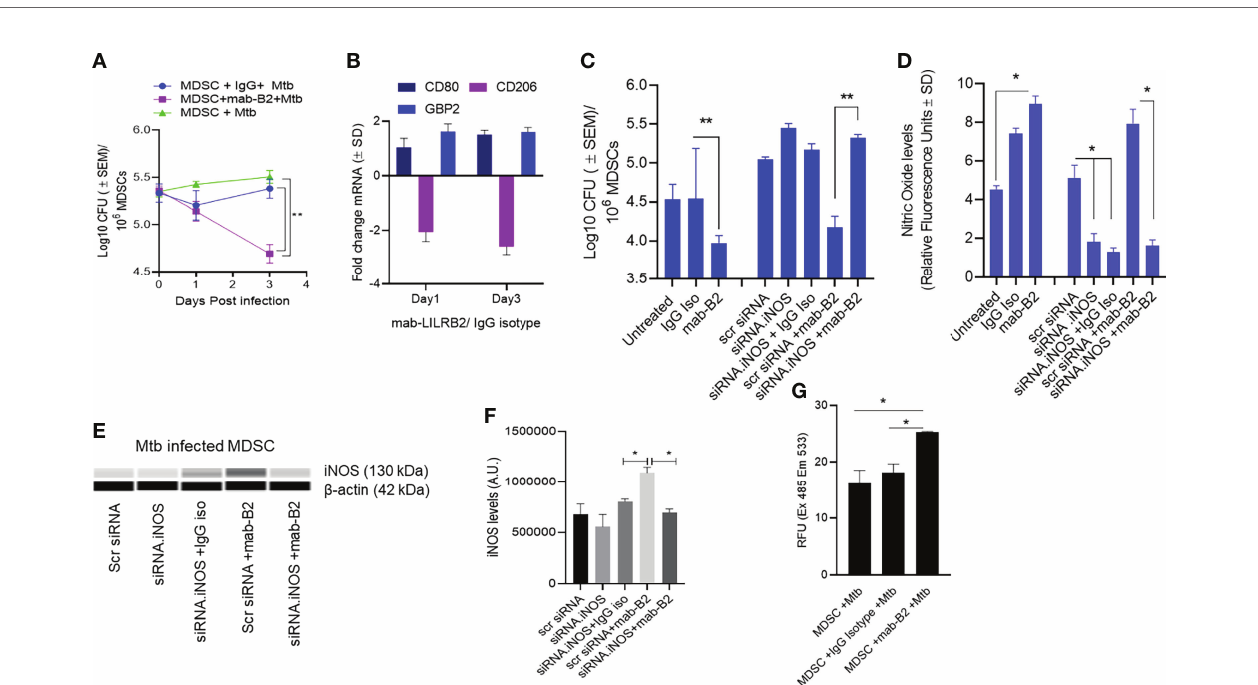
FIGURE 2 | A monoclonal antibody to leukocyte immunoglobulin-like receptor B2 (LILRB2) enhances the killing of Mycobacterium tuberculosis (Mtb) in MDSCs through nitric oxide. (A) CD14 + /CD33 + bead-puri fi ed M-MDSCs derived from GM-CSF/IL-6 cultured PBMCs of a healthy donor were infected for 4 h with Mtb H37Rv (MOI = 1), washed, and activated using either a monoclonal antibody to LILRB2 (mab-B2; 1 µg/ml) or its IgG isotype (1 µg/ml) or left untreated. MDSC lysates were plated at indicated time points for Mtb CFUs on 7H11 agar (triplicate wells per point; ** p < 0.007 1-way ANOVA and Tukey ’ s posttest; 1 of 2 similar experiments shown). (B) At indicated time points, MDSC cell lysates in trizol were collected for qPCR for CD80, CD206, and Guanylate binding protein-2 biomarkers (1 of 2 similar experiments shown). (C) MDSCs were treated with siRNA vs. inducible nitric oxide synthase ( iNOS ) or its scrambled control followed by 4 h Mtb infection (MOI = 1), washed, and activated using mab-B2 or its isotype and incubation for 3 days before CFU counts (triplicate wells per point; ** p < 0.009 1-way ANOVA; 1 of 2 similar experiments shown). (D) Replicates of panel C were incubated with Diamino fl uorescein diacetate followed by a fl uorometric detection of soluble nitrite in medium (triplicate wells per point; * p < 0.009 t -test; 1 of 2 experiments shown). (E) Cell lysates of panel C were tested for iNOS protein using ProteinSimple-Wes capillary electrophoresis. Expression of iNOS was normalized to b -actin. Supplementary Figure 2 illustrates the Wes-capillary gel analysis. (F) Densitometry of proteins for panel E (* p < 0.001 t -test). (G) Relative production of reactive oxygen species (ROS) by MDSC with and without treatment of mab-B2 following Mtb infection. ROS was detected using dihydro-dichloro- fl uorescein aceate and fl uorometry (* p < 0.001 t